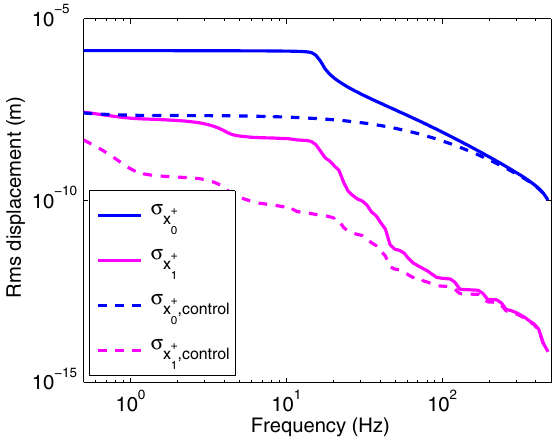
FIG. 17. Integrated rms when the control is turned on and